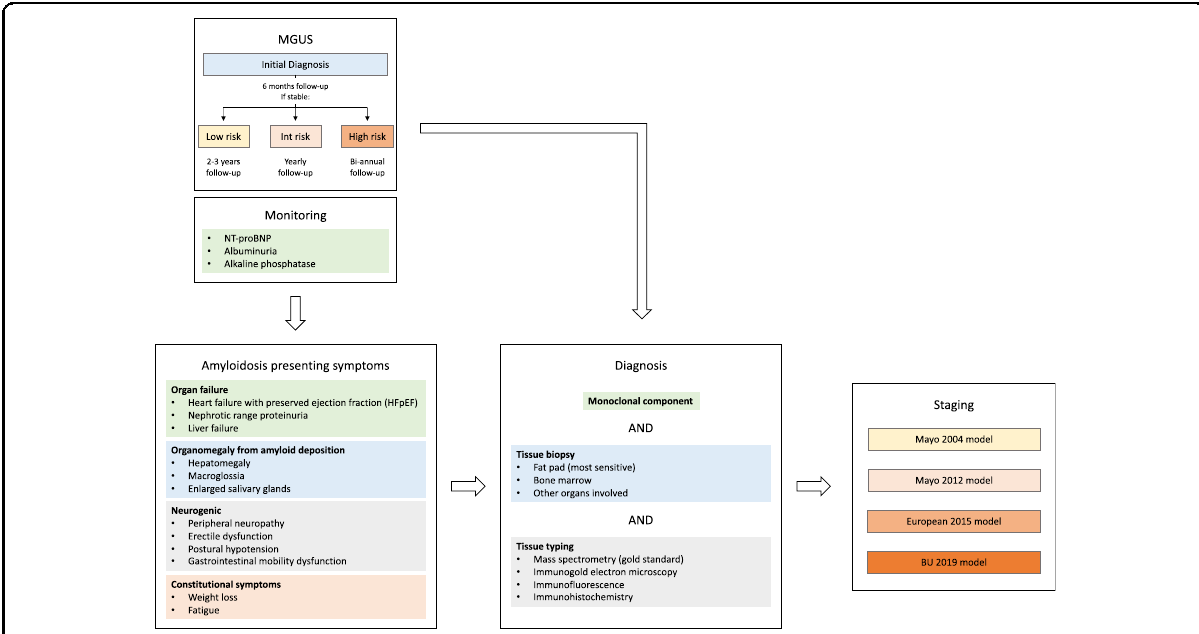
Fig. 1 Monitoring, presenting symptoms, anddiagnosis of AL amyloidosis. MGUS monoclonal gammopathy of undetermined signi fi cance, NT-proBNP N-terminal pro b-type natriuretic